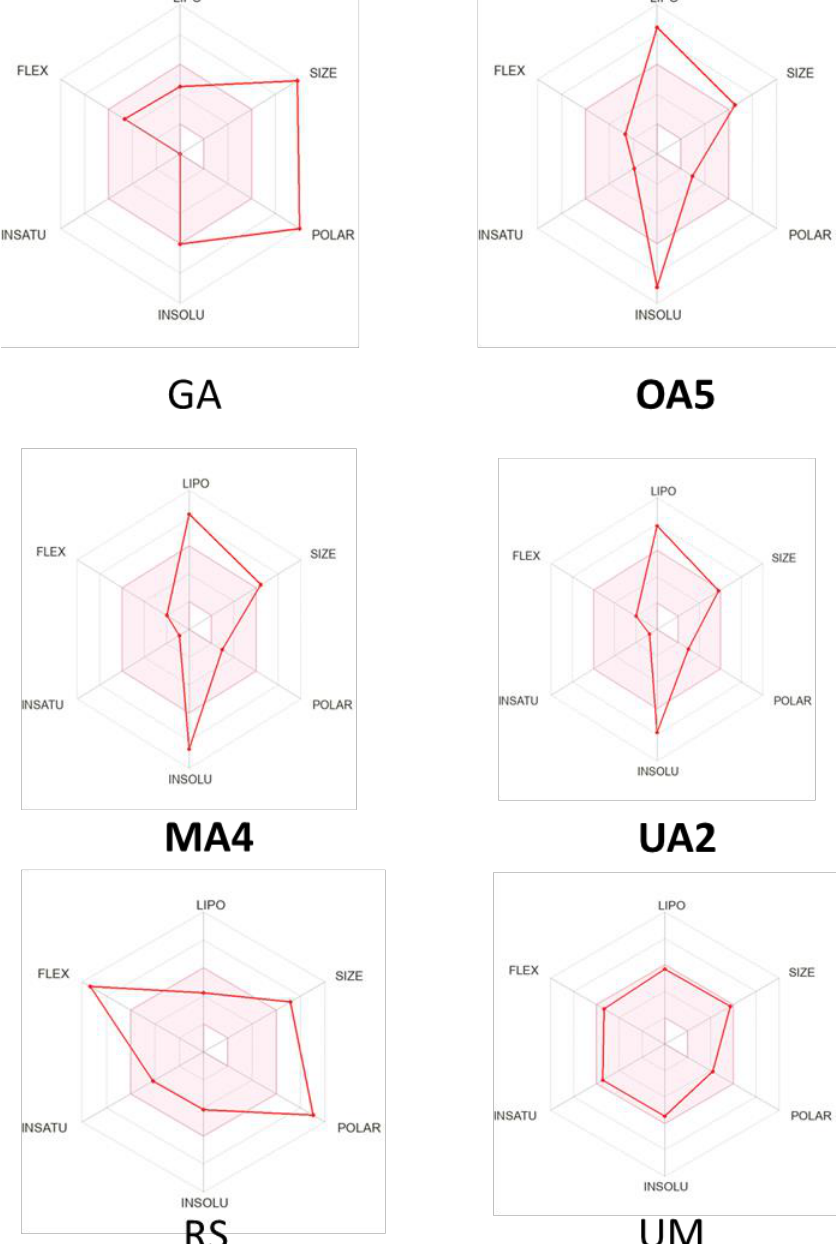
Figure 10. Bioavailability radars for GA, RS, UM, OA5 , MA4 and UA2 . The pink area represents the optimal range for each property. Table 2. Structural and physicochemical properties of the top selected derivatives and the reference molecules.